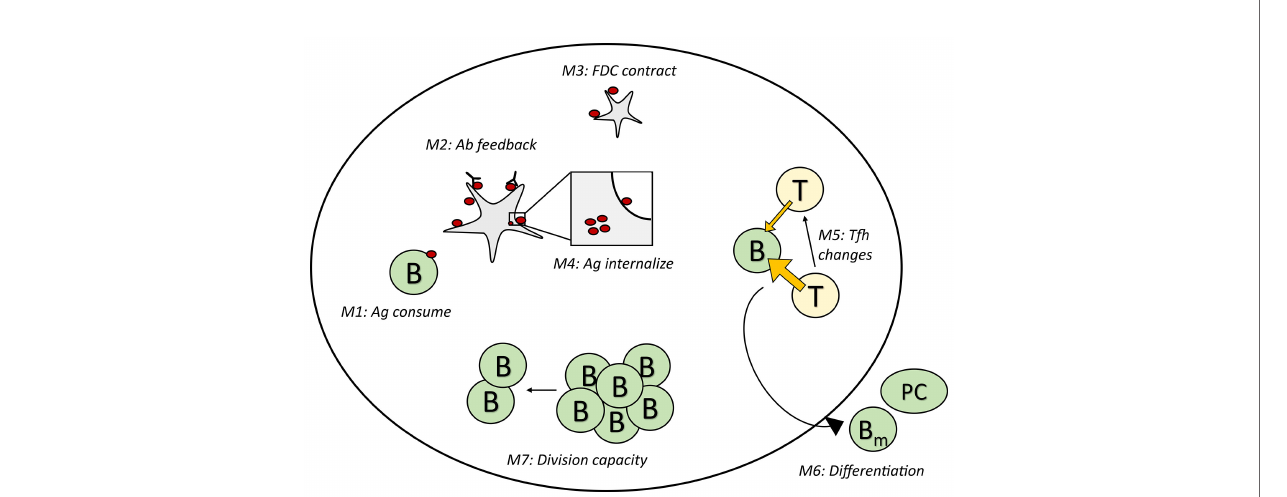
FIGURE 1 | Schematic representation of the GC shutdown mechanisms. In mechanisms M1-M4, antigen limitation arises due to the consumption of antigen by B cells, masking of antigen by soluble antibodies (antibody feedback), contraction of FDC network and changes in antigen cycling rate constants leading to increased internalization of antigen, respectively. In M5, Tfh signaling intensity decreases leading to limiting T cell help. In M6, increased terminal differentiation of GC B cells into memory/plasma cells leads to increased exit from GCs. In M7, B cells have limited capacity to divide leading to decreased proliferation over time. GC, Germinal center; FDC, Follicular Dendritic Cell; T/Tfh, T follicular helper cell; Ab, Antibody; Ag, Antigen; PC, Plasma cell; B m , Memory B cell; B, Germinal center B cell.